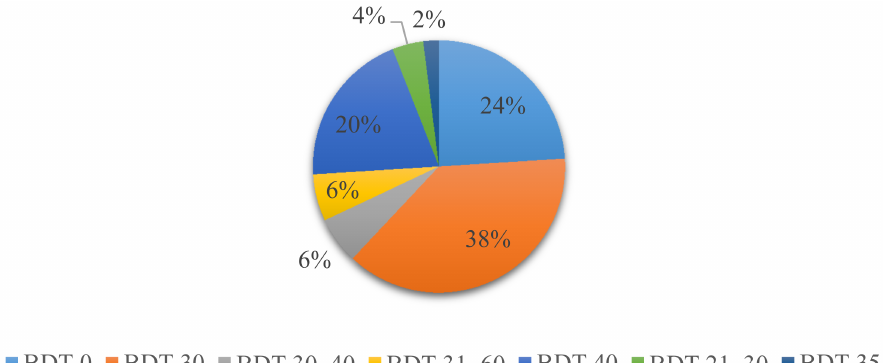
Figure 9. Comparison of monthly fees paid by the